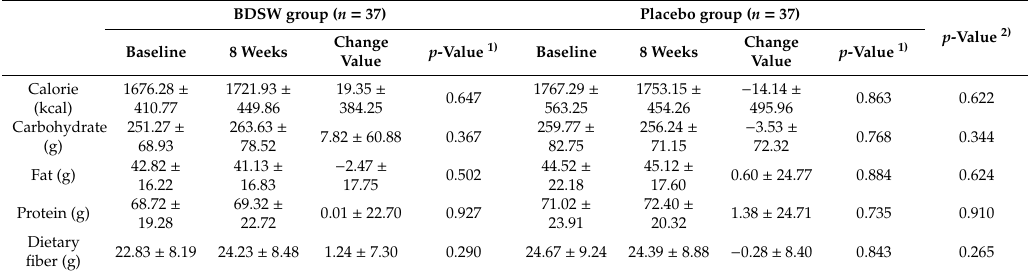
Table 7. Dietary intake analysis before and after ingestion.